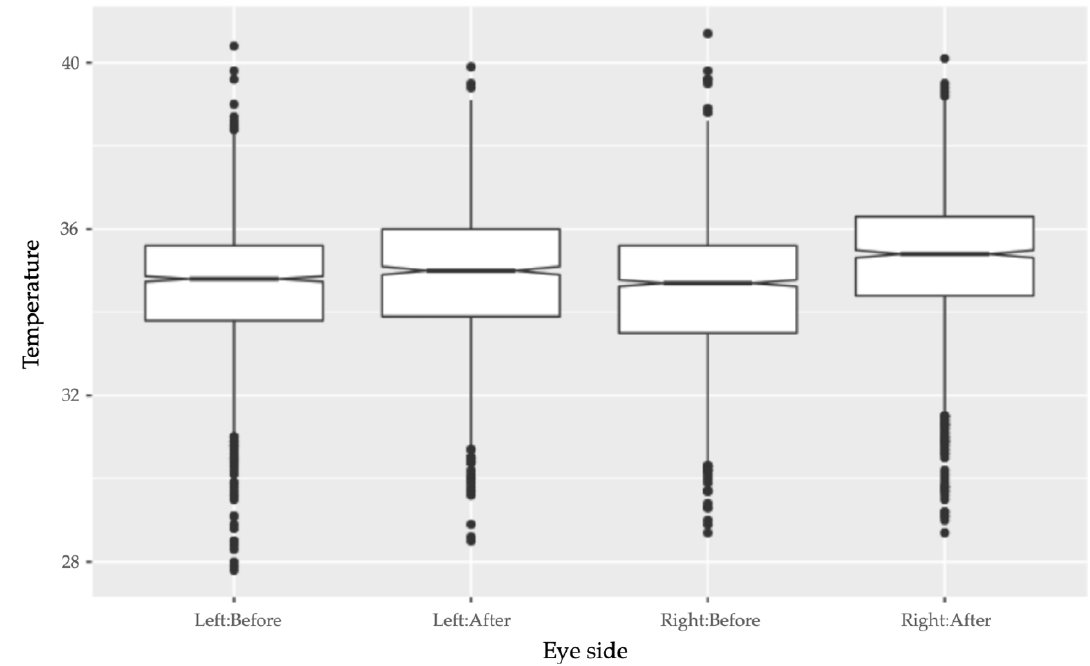
Figure 3. Boxplot showing how temperatures of both the right and left eyes increased after racing. Compared to the left eye, the right eye had a higher increase in temperature after the race.